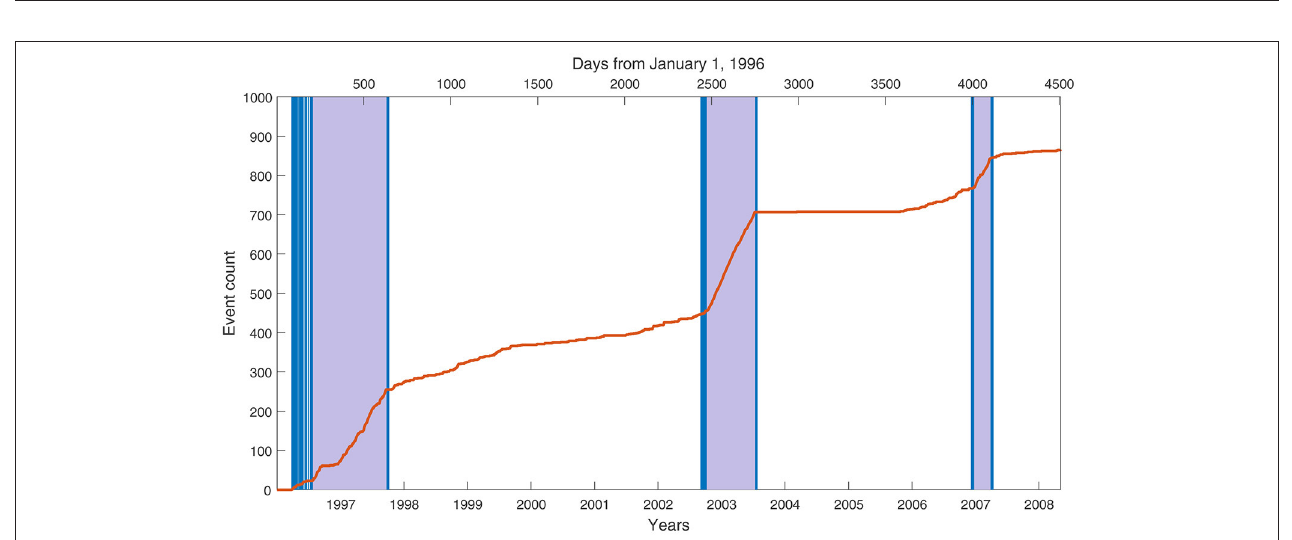
from low to high. This may, for example, impact decisions on the timing of enlarging no-entry zones when faced with indications of newly heightened activity